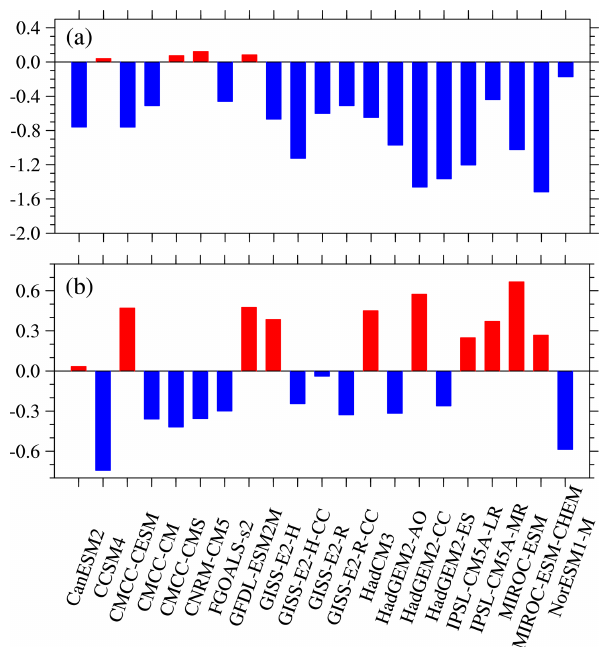
Figure 9. Difference in the amplitude of the PIOAMI in the positive phase (a) and negative phase (b) between the CMIP5 models and HadISST